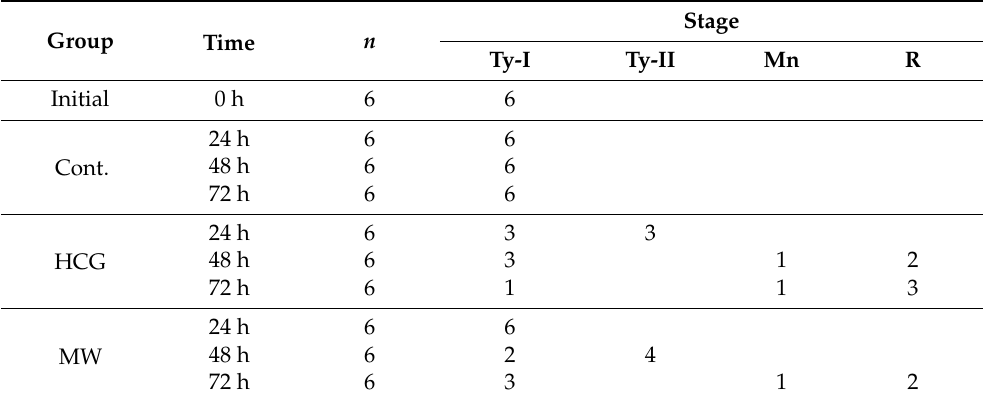
Stage Ty-I Ty-II Mn R